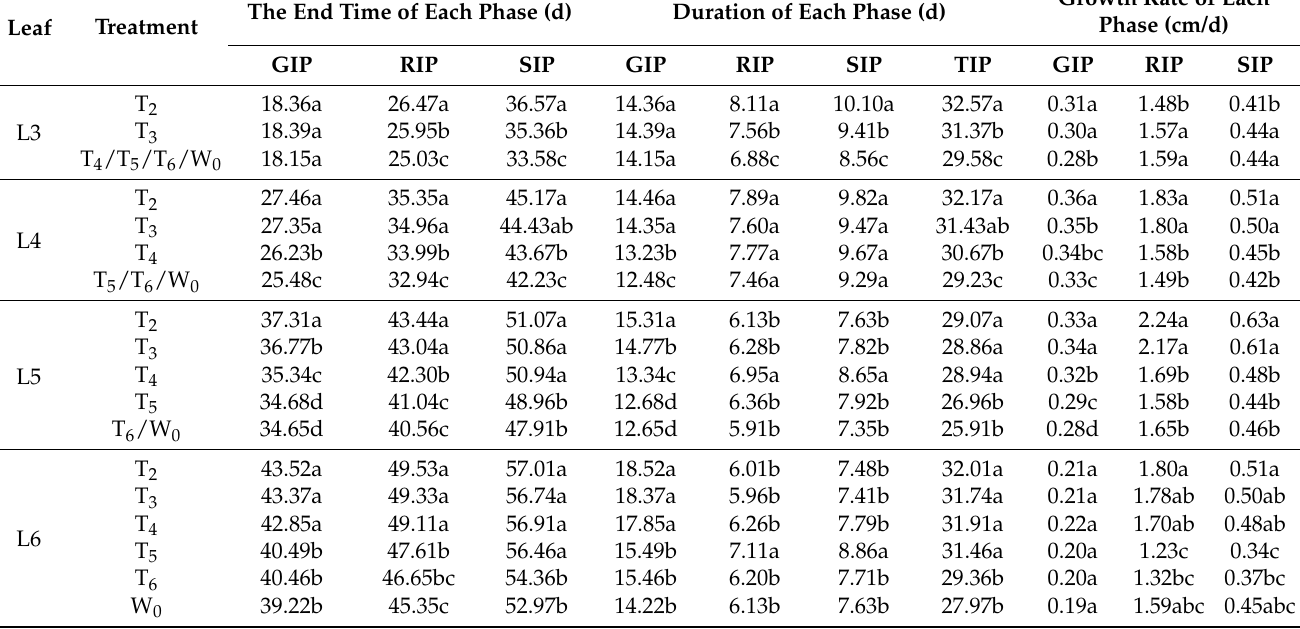
Table 3. Characteristic parameters of the growth process of each leaf in the growing season from 2020 to 2021.